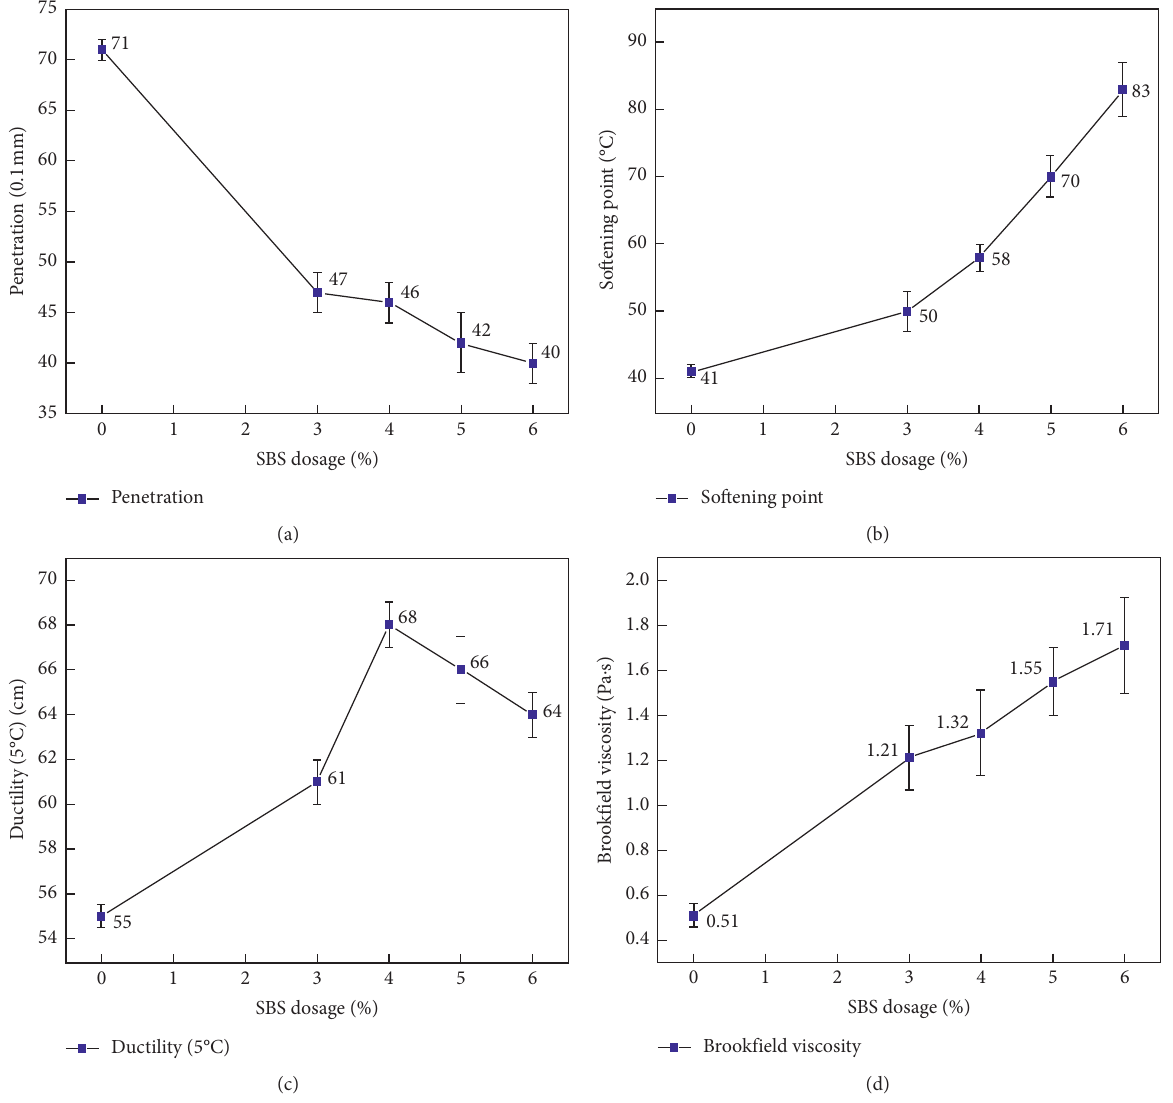
Figure 1: Single factor test results of SBS variation. (a) Penetration test results. (b) Softening point test results. (c) Ductility test results. (d) Brookfield viscosity test